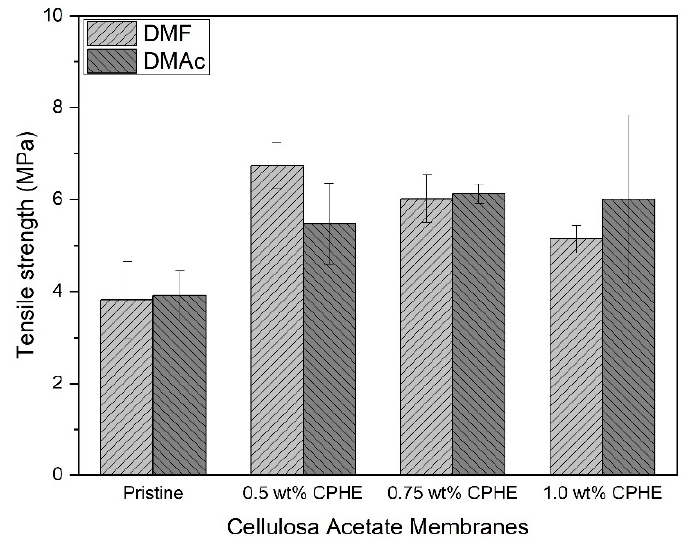
Figure 6. Tensile strength of the cellulose acetate membrane sheets.